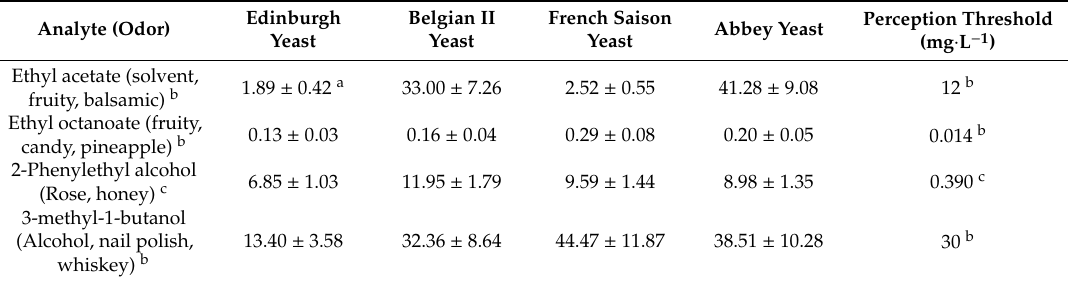
Table 3. Important aroma compounds quantified in cider fermented (six months) with the same apple juice and di ff erent S. cerevisiae yeast strains a